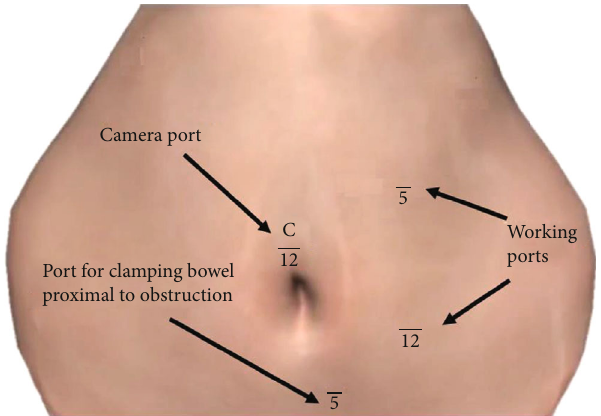
Figure 5: Port placement for gallstone extraction and repair of enterotomy.